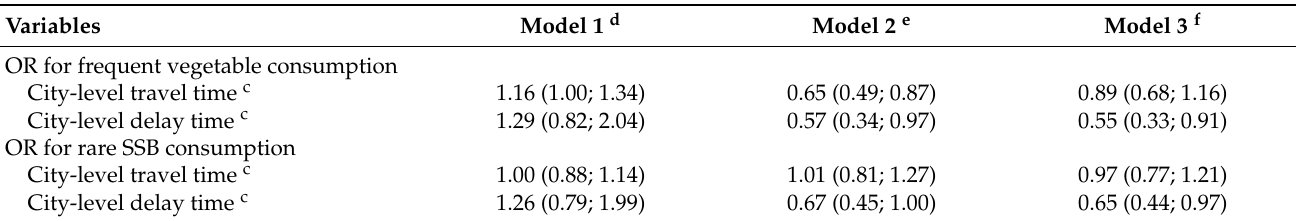
Table 3. Odds ratios of individual vegetable frequent consumption (N = 57,170) a and sugar- sweetened beverage (SSB) rare consumption (N = 42,117) b , associated with city level travel and delay time in LA cities.